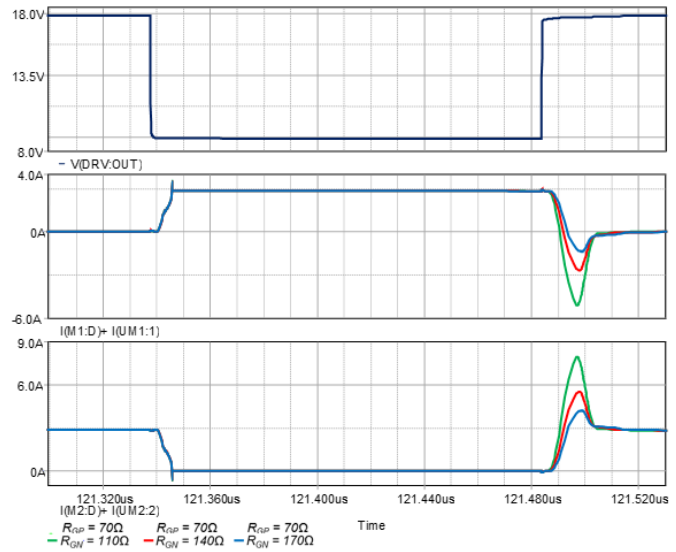
Figure 7. SPICE simulation of total currents of the drains and bypass diodes of the M1 and M2 transistors during single DPWM signal period for different turn-on delay times.